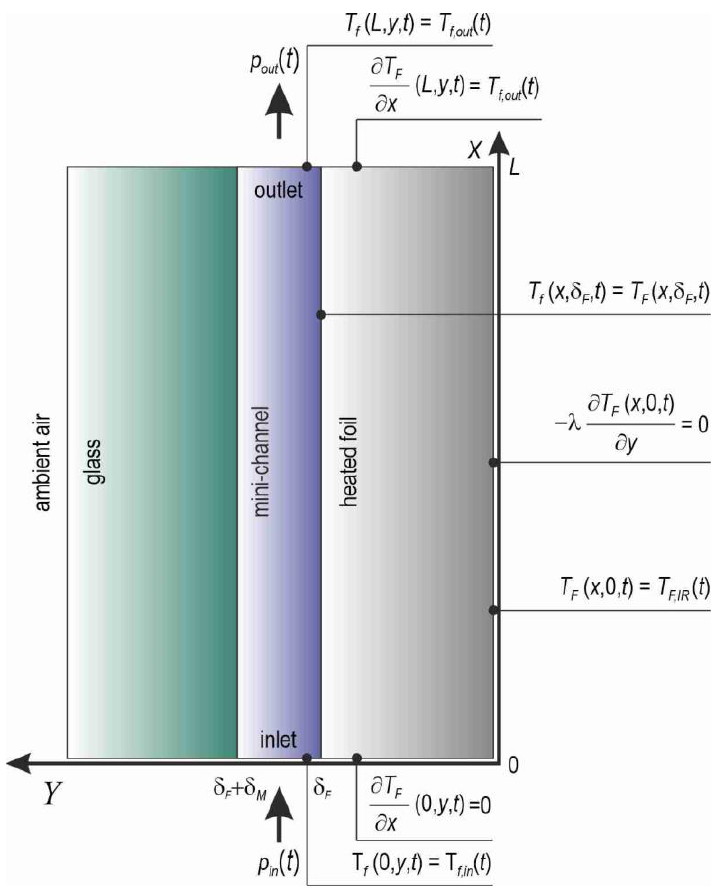
Figure 3. Boundary conditions.